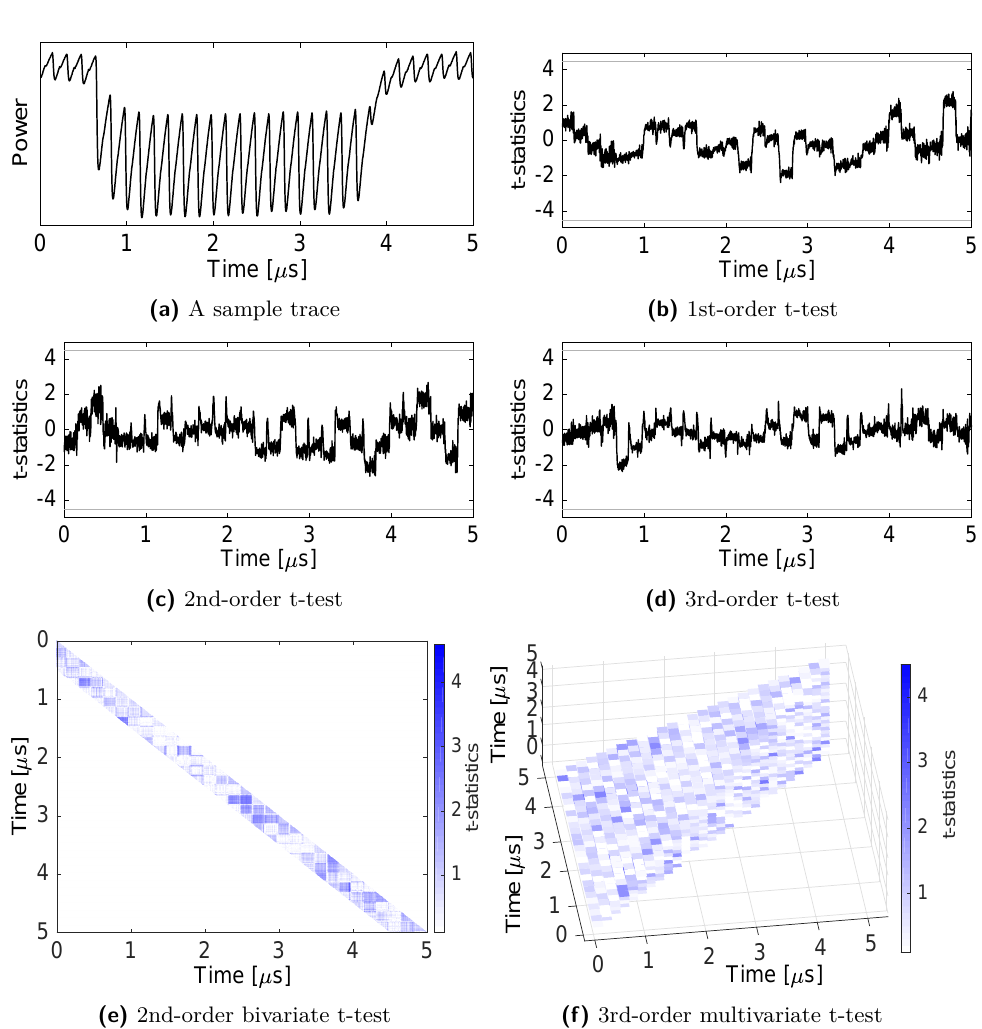
Figure 6: Experimental analysis of our three-share Keccak - f [200] design using 100 million